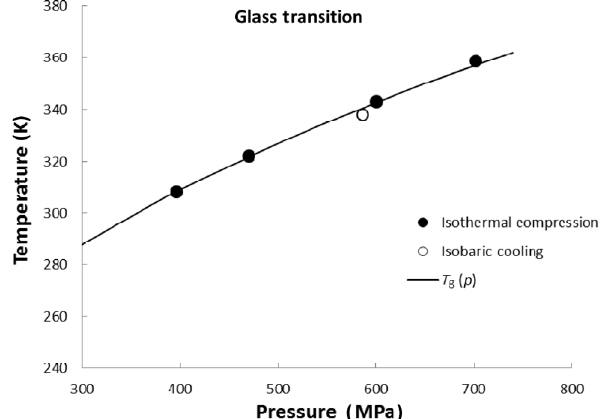
Fig. 1 The glass transition detected in isobaric cooling at pressure of 586 MPa. The arrow indicates the time sequence in which the measurements were made.